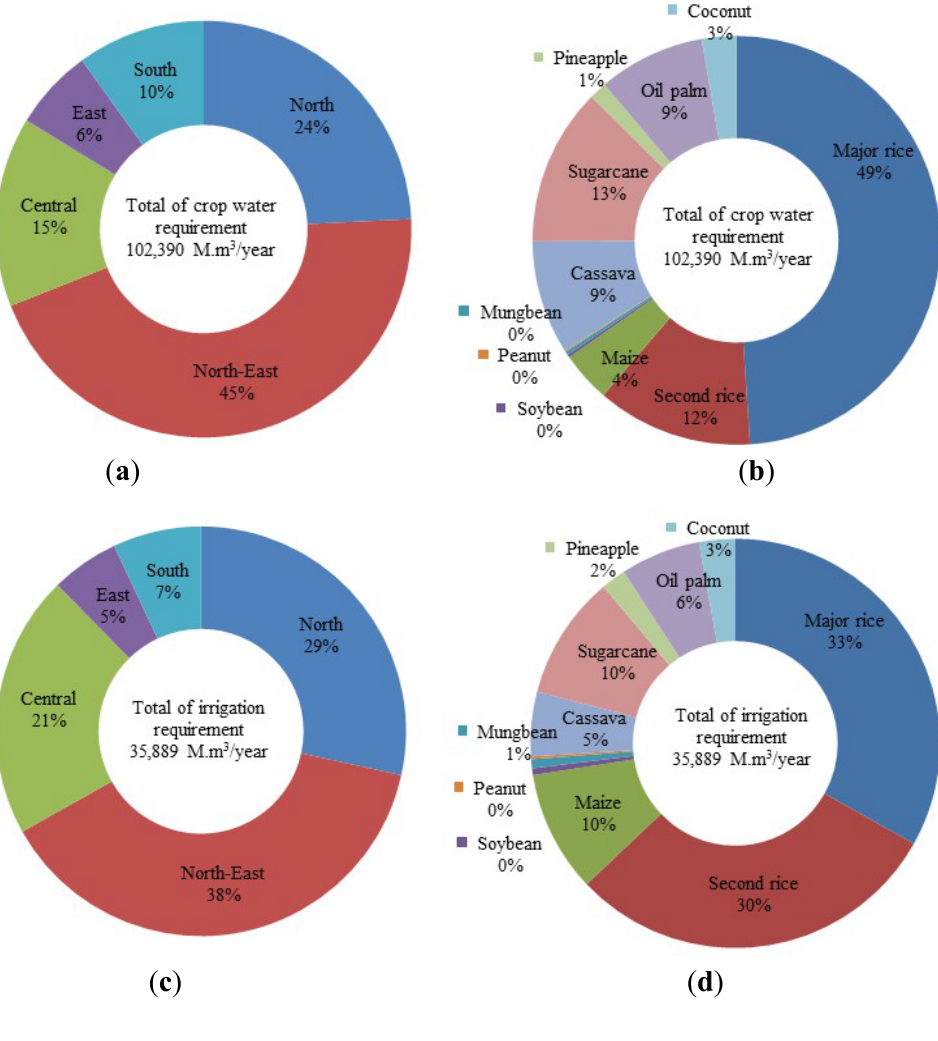
Figure 3. Total and Irrigation water requirements for crops cultivation classified by regions and products. ( a ) Total water requirements for crops cultivation classified by regions; ( b ) Total water requirements for crops cultivation classified by products; ( c ) Total irrigation water requirements for crops cultivation classified by regions; ( d ) Total irrigation water requirements for crops cultivation classified by